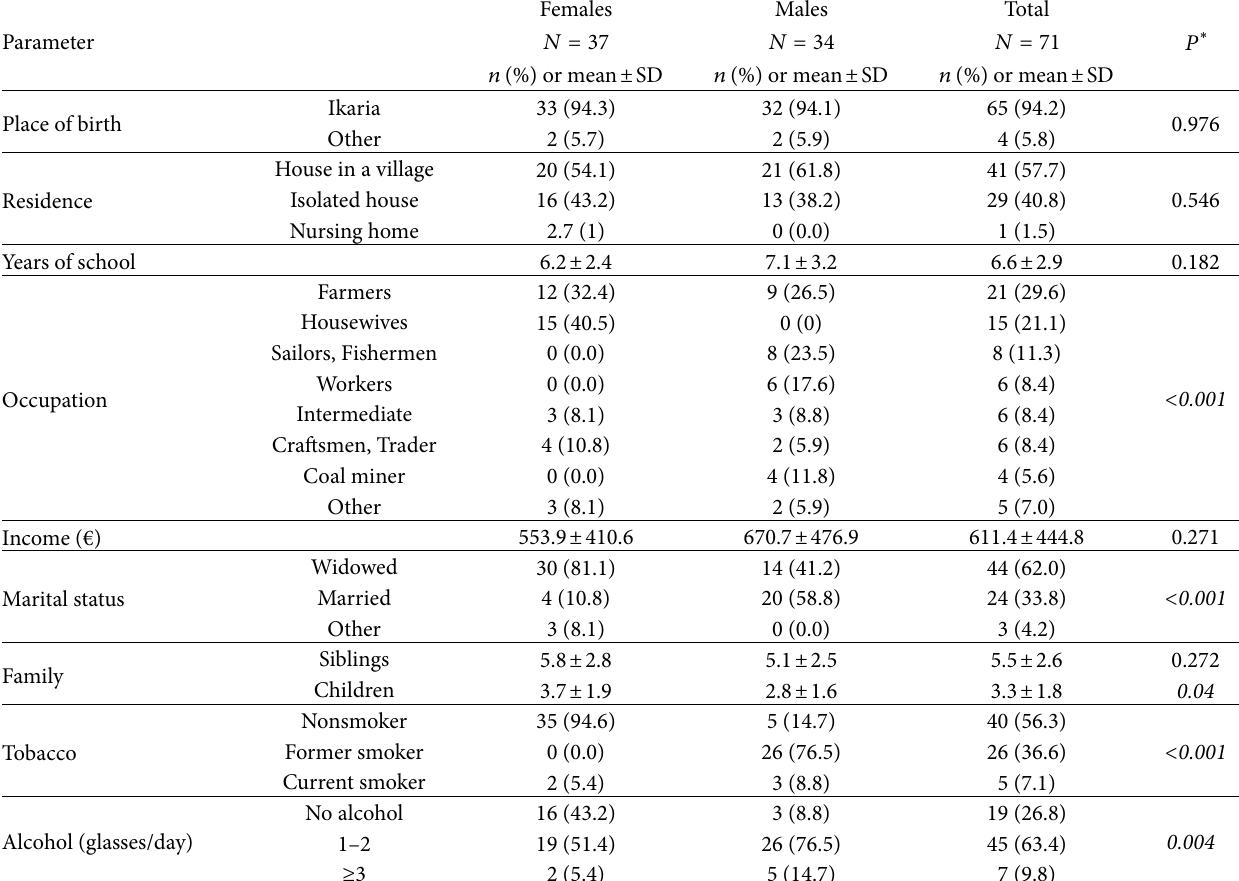
Table 2: Socio-demographic characteristics of